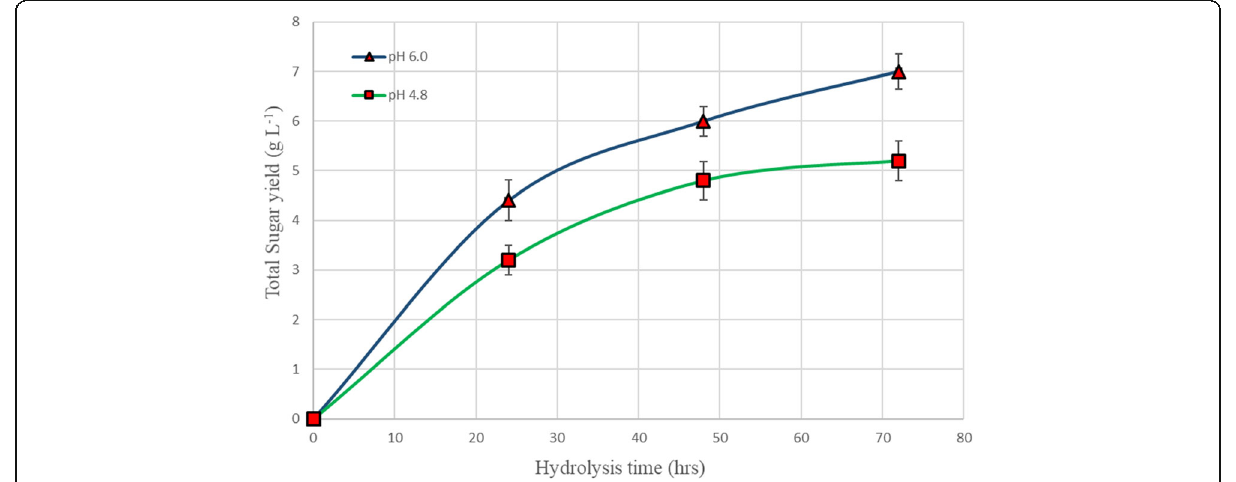
Fig. 3 Total reduced sugar yield at the end of hydrolysis (72 h) for pH 4.8 and